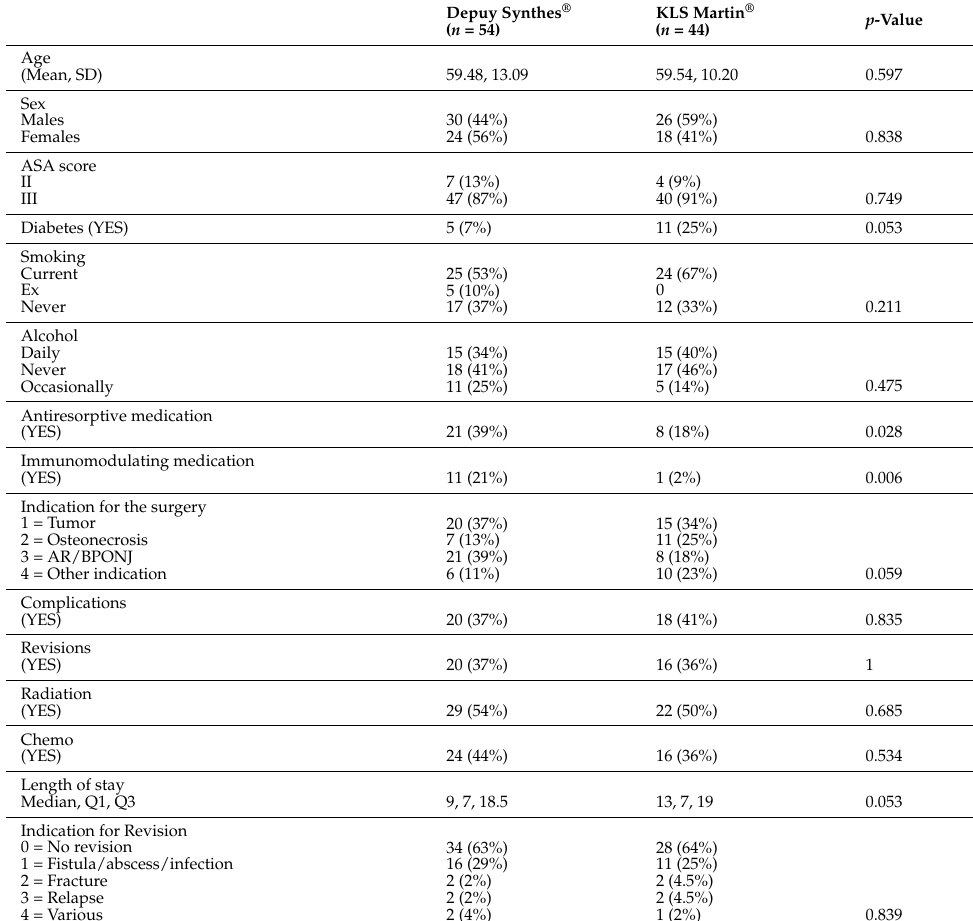
Table 1. Baseline demographic features comparison for system